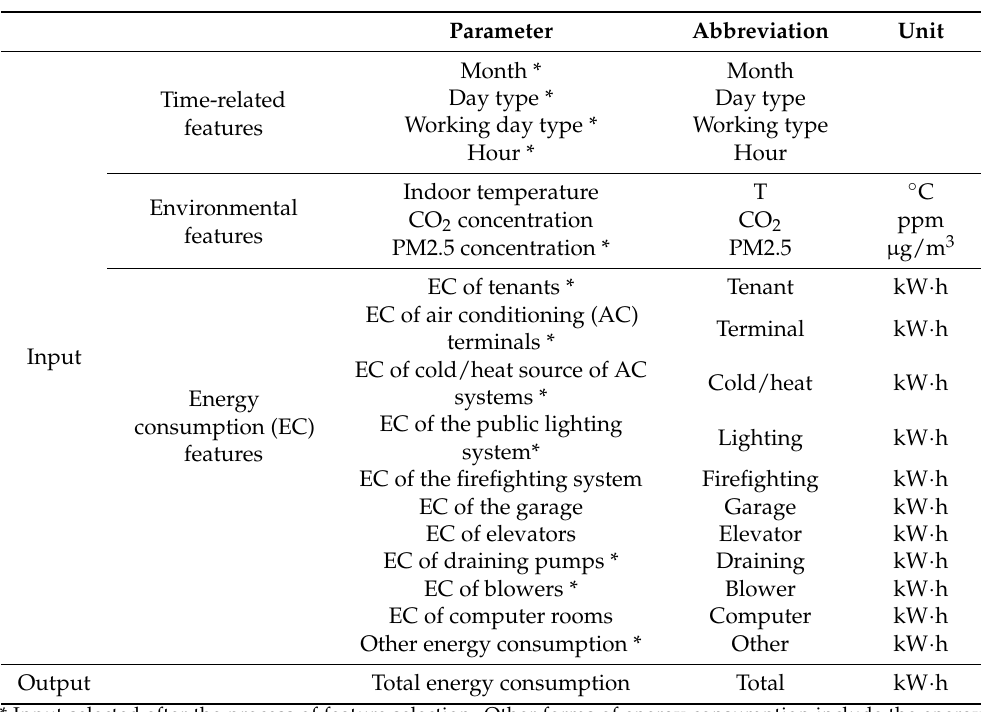
Table 2. Initial inputs and one output of the energy consumption prediction